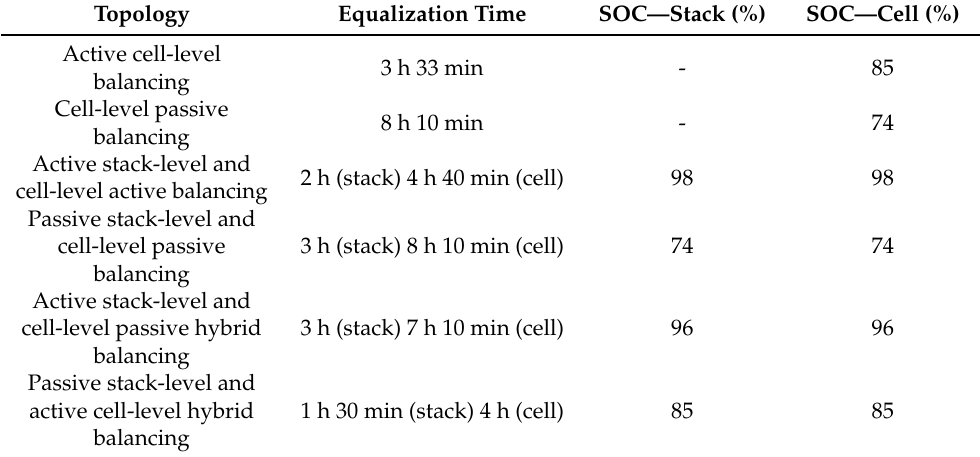
Table 3. Comparison of equalization topologies.